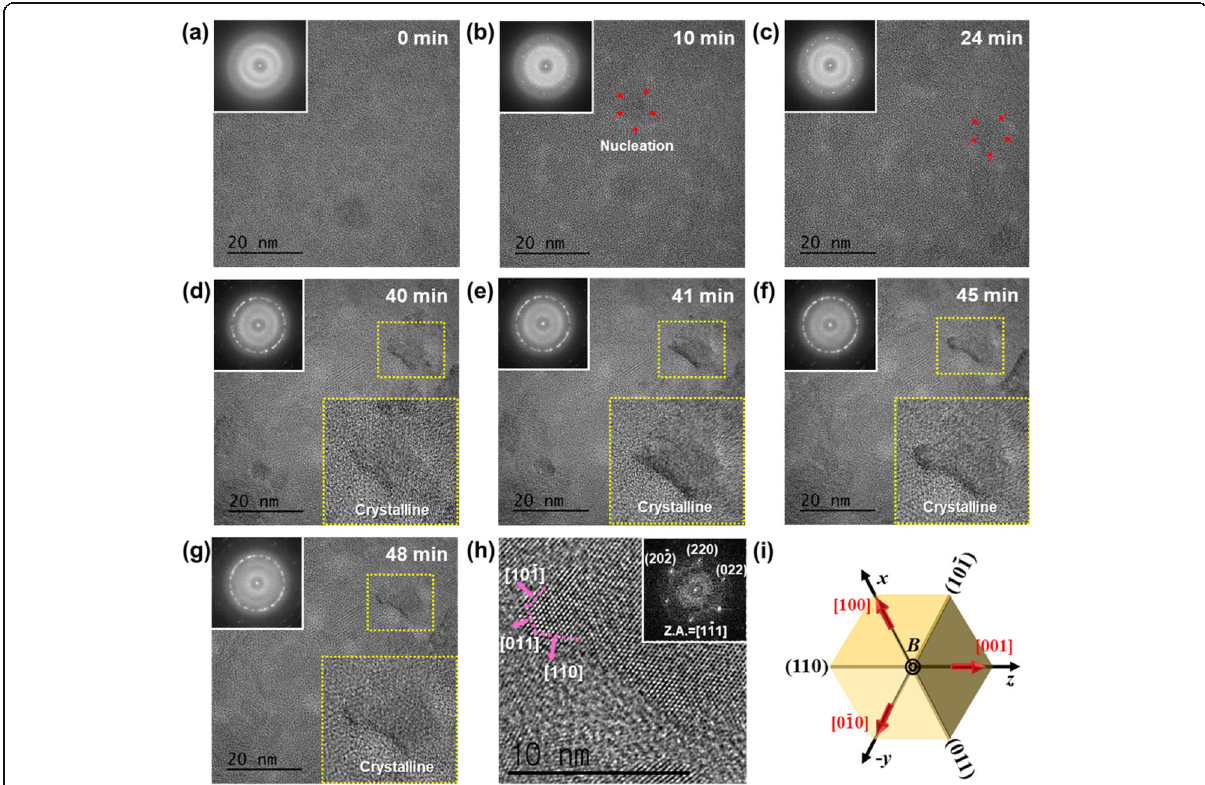
Fig. 1 Real-time TEM images and FFTs diffractograms in the inset for the amorphous Ge 2 Sb 2 Te 5 film during 200 keV electron beam